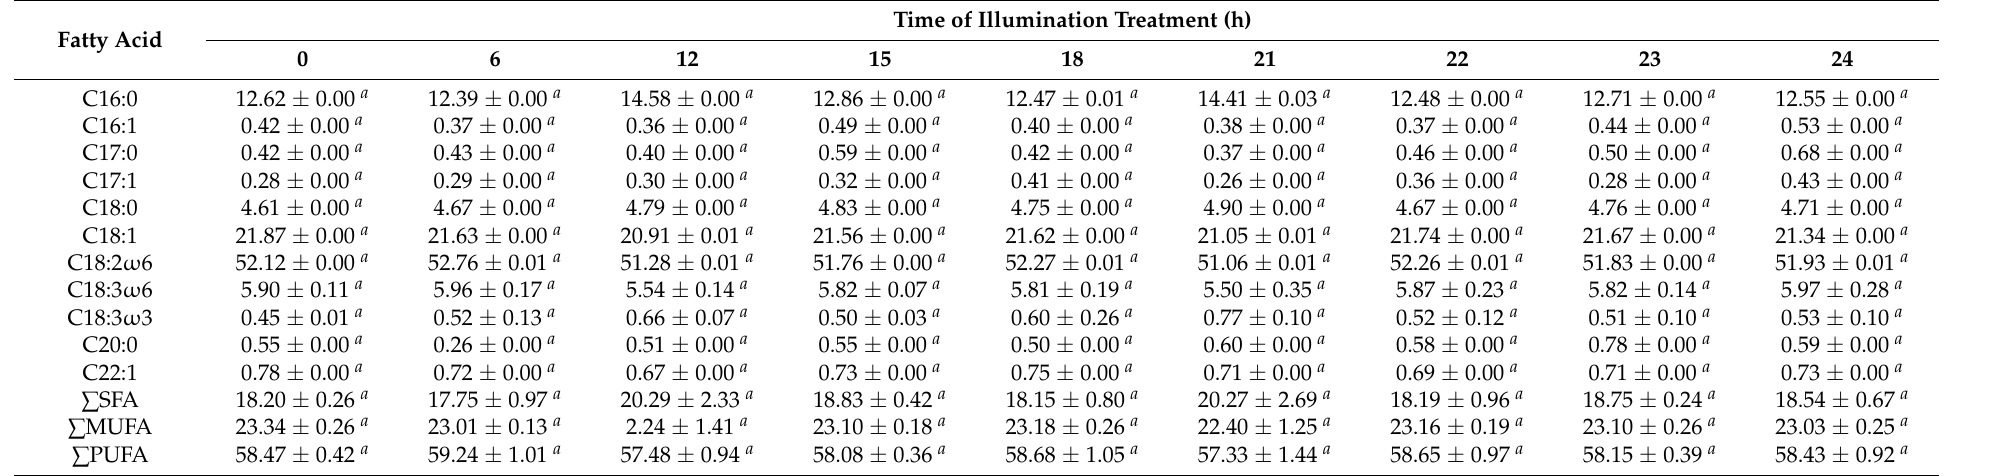
Table 1. The fatty acid composition of the activated clay bleached soybean